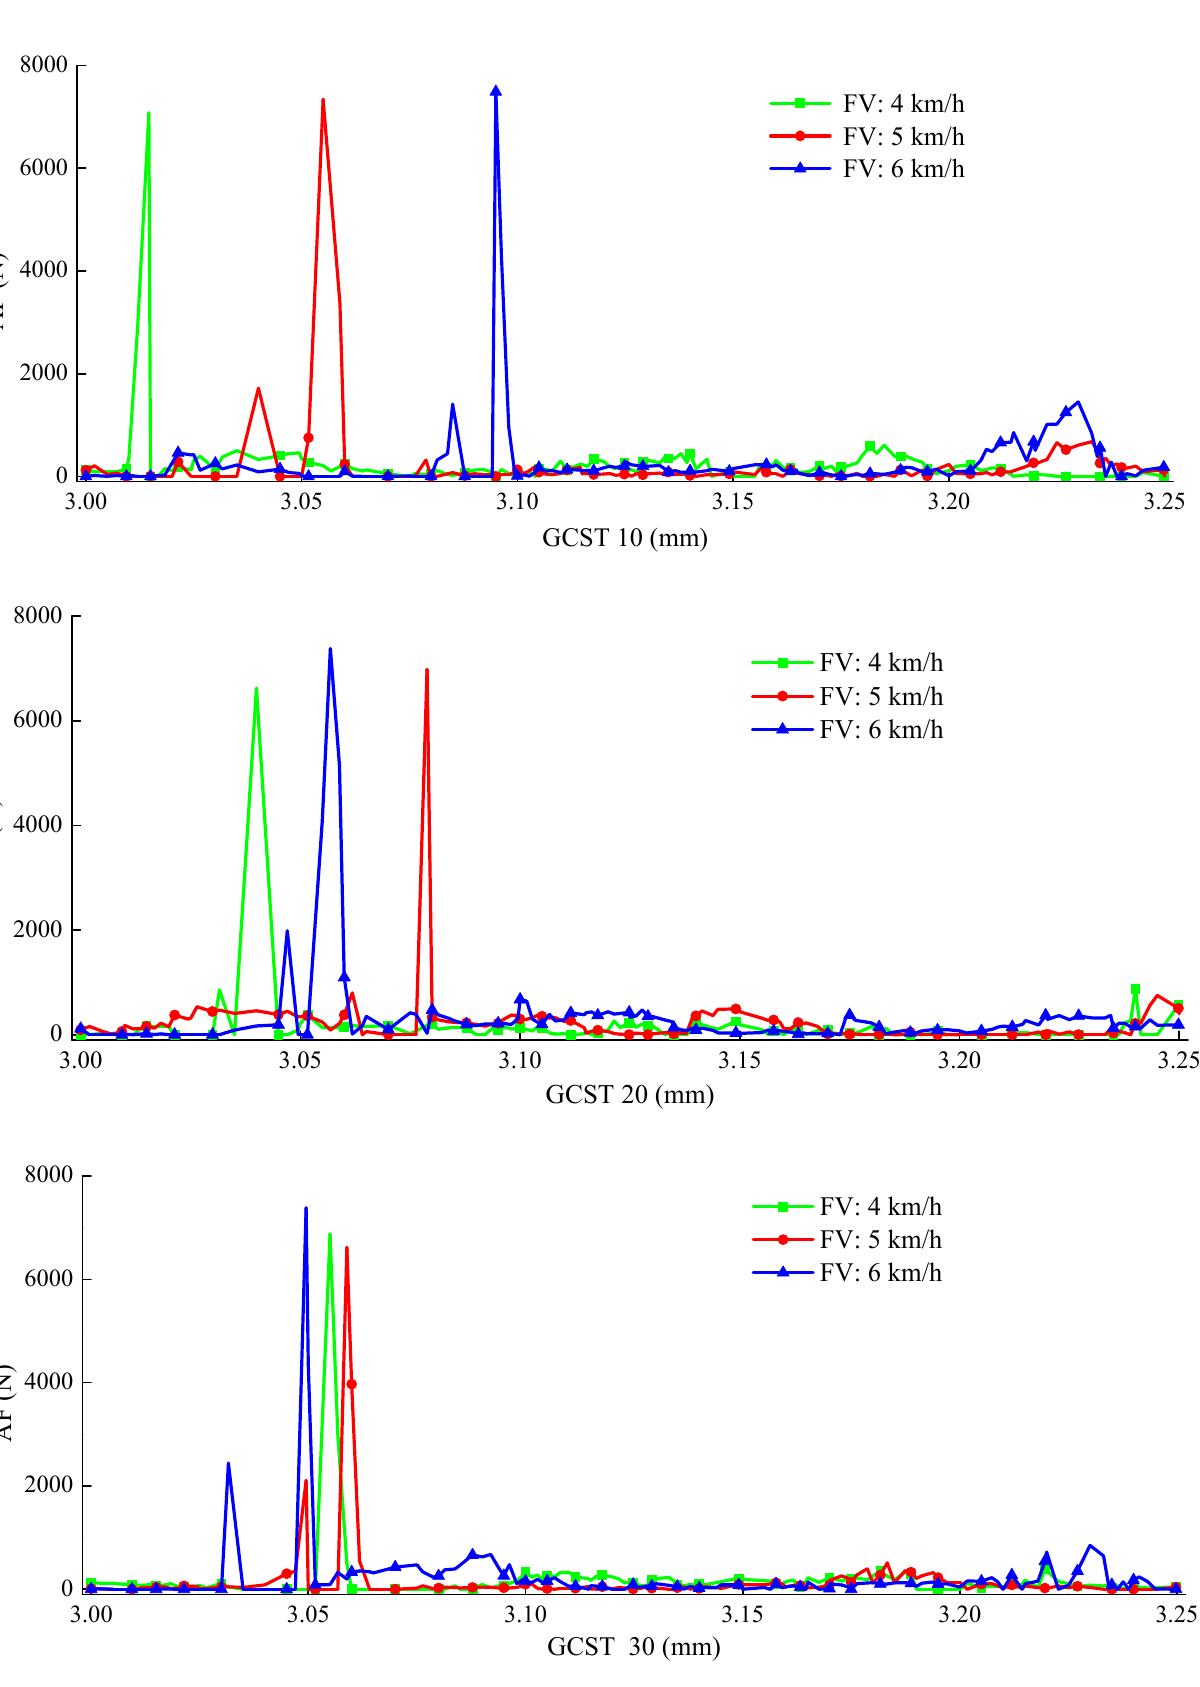
Figure 12. AF variation at different FV.